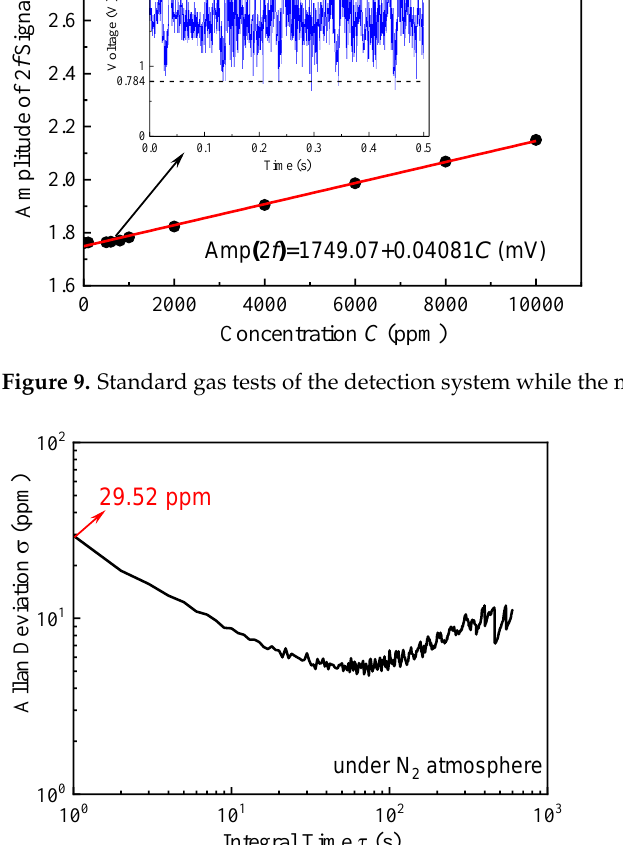
Figure 10. Allan deviation of the developed system under N 2 gas in the gas